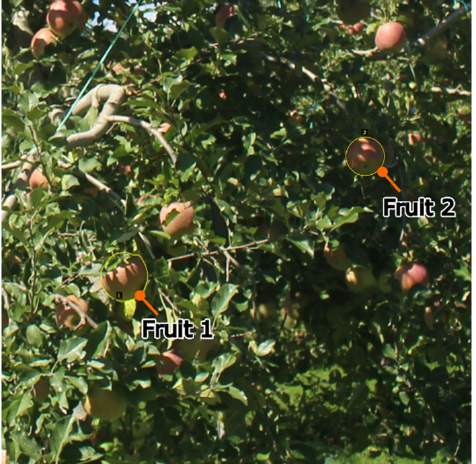
Figure 8. Examples of a validation image. One image from each day in which the fruit is clearly visible was selected from the 1417 farm images recorded over 137 days from 1 July to 15 November, 2016.